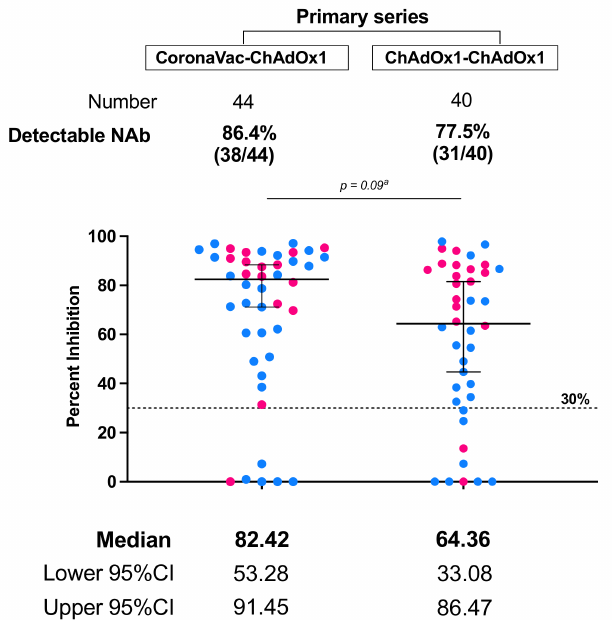
Figure 3. ELISA-based surrogate neutralization against Omicron BA2 variant in response to the CoronaVac/ChAdOx1/mRNA versus the ChAdOx1/ChAdOx1/mRNA vaccination in cancer pa- tients. Data are reported as the median and 95%CI of percentage of inhibition between human ACE-2 and RBD protein. The cut-off value of 30% indicates the presence of detectable neutralization ac- cording to the manufacturer’s (cPass, Genscript) protocol. Data points represent individual samples. The pink color represents chemotherapy and the blue color represents treatment with hormonal therapy/biologics. a Mann-Whitney